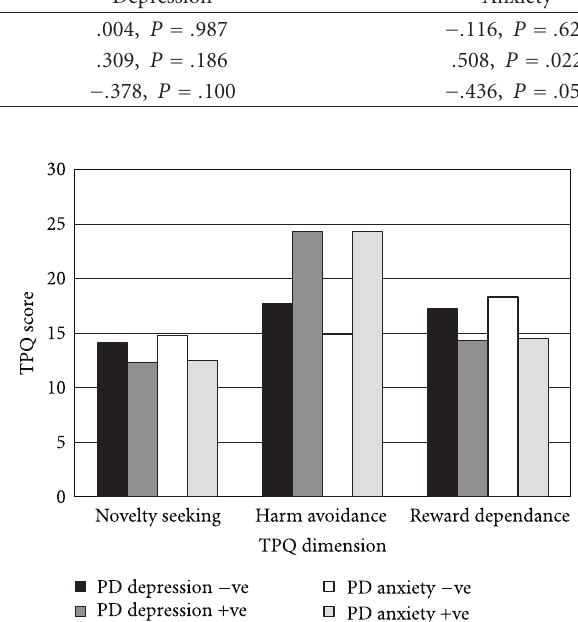
Figure 3: Comparison of Tridimensional Personality Questionnaire scores for PD participants with or without probable depression or